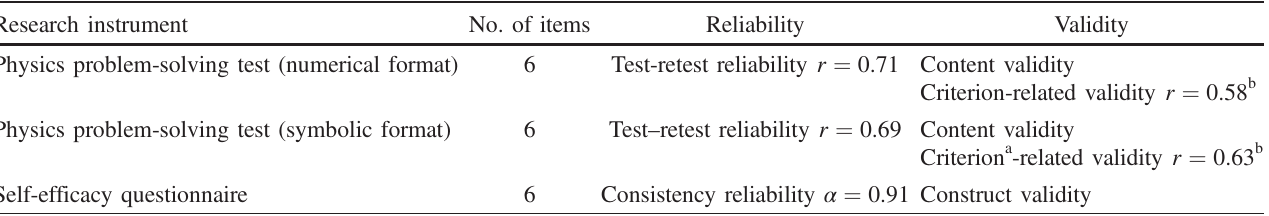
TABLE II. Research instruments and their reliability and validity. Research instrument